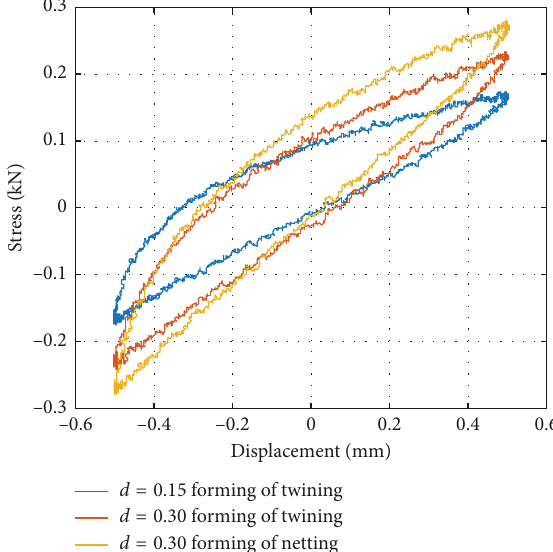
Figure 16: Hysteresis loop of MR under different processes.